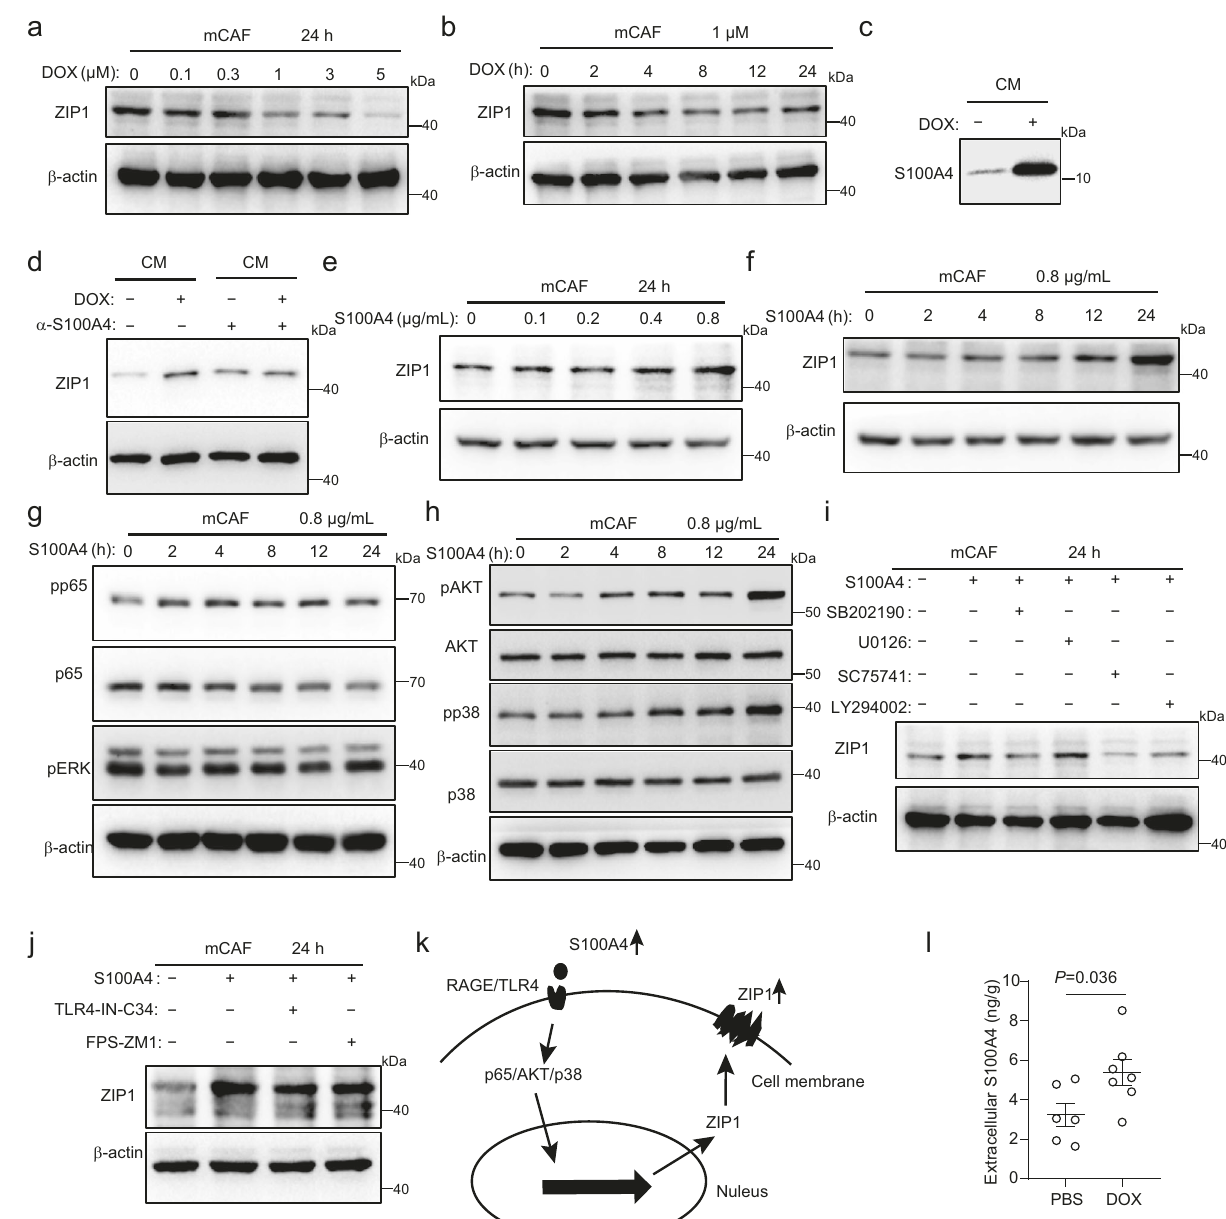
Fig. 7 | S100A4 increases ZIP1 expression in fi broblasts. a , b ZIP1 expression in mCAF treated with DOX at the indicated doses ( a ) or for the indicated times ( b ). Representative results from three ( a , b ) independent experiments are shown. c S100A4levelsinthesamevolumeofLLC-GFP-luccellculturemediums(CMs)with or without DOX treatment determined by western blotting. The same number of tumour cells were seeded and pre-treated with DOX (1 μ M) for 6h. Twenty-four hours after changing the fresh medium, CMs were collected. The same volume of CM from different treatment groups was analysed by Western blotting. A repre- sentativeresultfromthreeindependentexperimentsisshown. d ZIP1expressionin mCAFtreatedwithindicatedCM.ForS100A4neutralisation,CMwaspre-incubated with α -S100A4 antibody 3B11 (6 μ g/mL) for 1h. A representative result from four